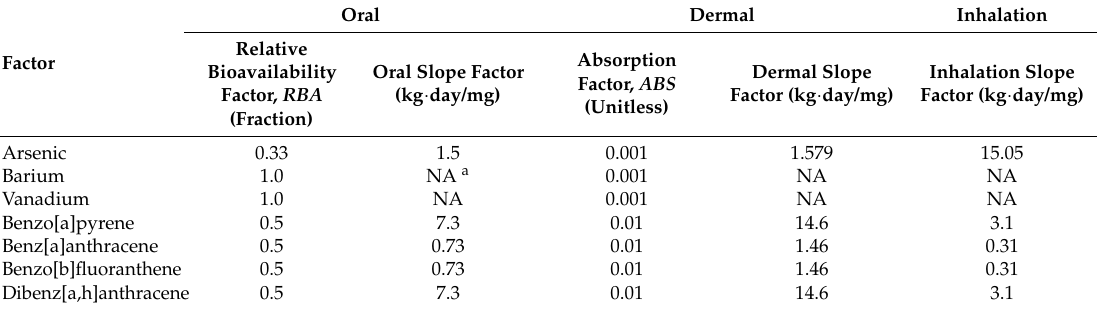
Table 4. Chemical dependent factors for oral, dermal and inhalation exposure routes. All factors in this table came from CEHT [31], which provide references to primary sources.